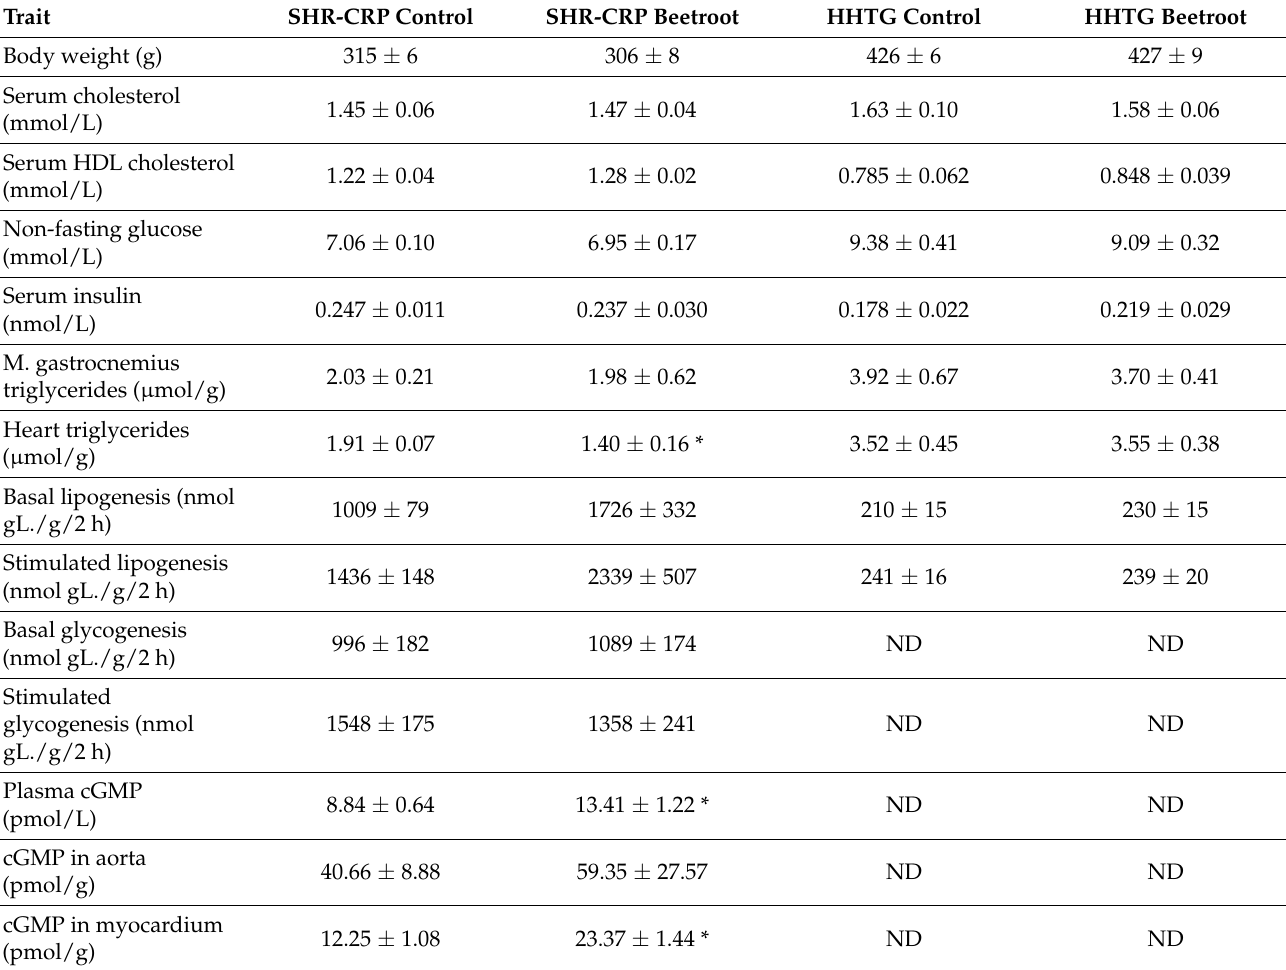
Table 1. Parameters of glucose and lipid metabolism in SHR-CRP and HHTg rats treated with beetroot juice and in their untreated controls. ND denotes not determined. * denotes p <